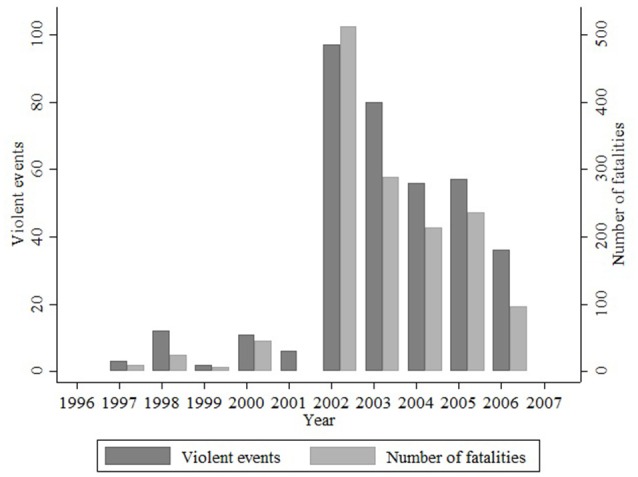
Civilian targeting.